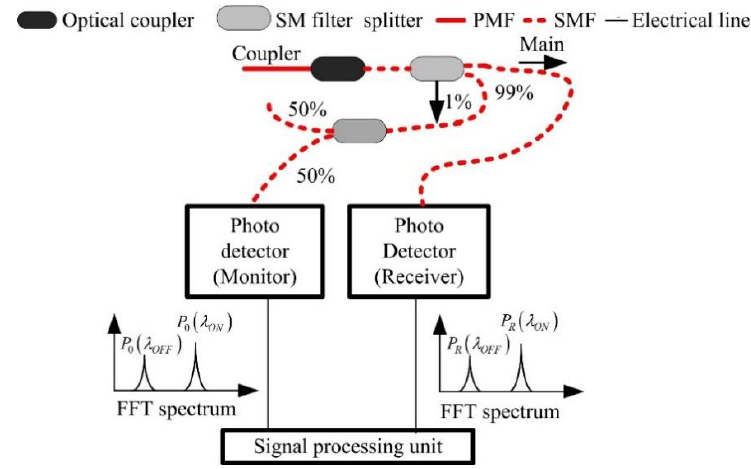
Figure 3. Schematic of the setup for the optical fiber link test (OFLT) unit.